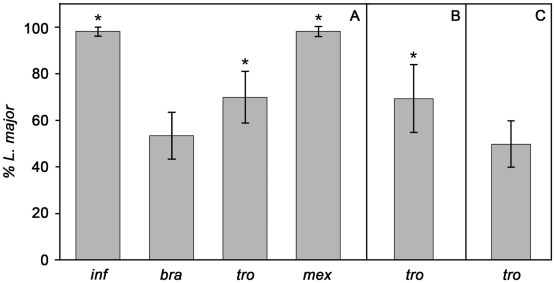
Binding of L. major to midguts from sand fly species in the presence of various Leishmania species (6 experiments).(A) Binding to P. papatasi midguts. (B) Binding to Lu. longipalpis midguts. (C) Binding to P. sergenti midguts. Competing species: inf  =  L. infantum FVI; bra  =  L. braziliensis; tro  =  L. tropica; mex  =  L. mexicana. Bars represent the mean percentage contribution of L. major in the bound population ± S.D. and the asterisks indicate a significant difference to the L. major population (>20 dissected guts examined per experiment).